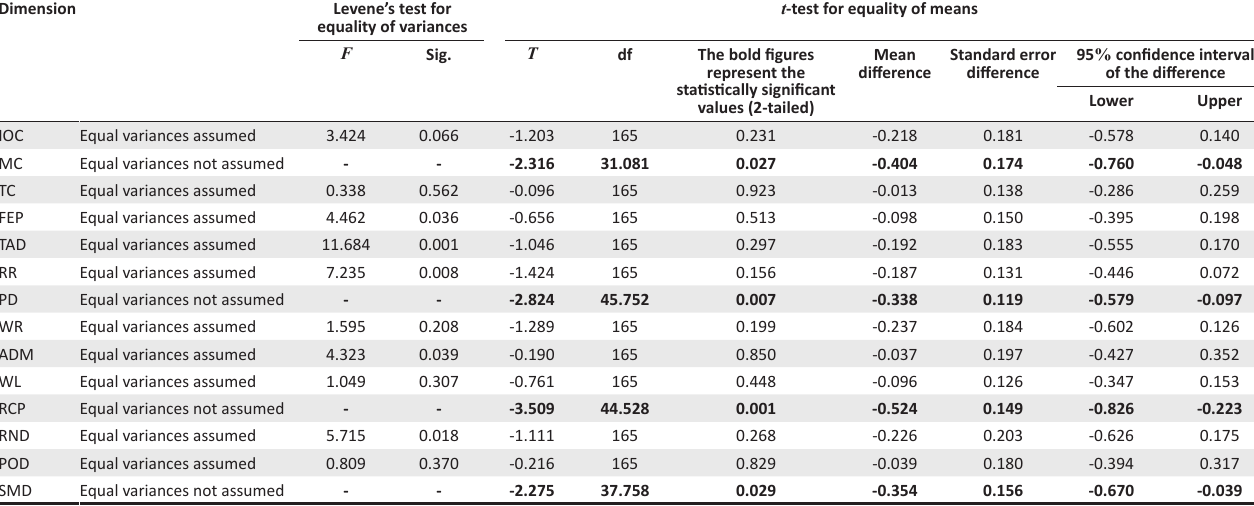
TABLE 8: Comparison of employment equity and employee morale perceptions between white and non-white employees. Dimension Levene’s test for equality of variances F Sig. T df The bold figures